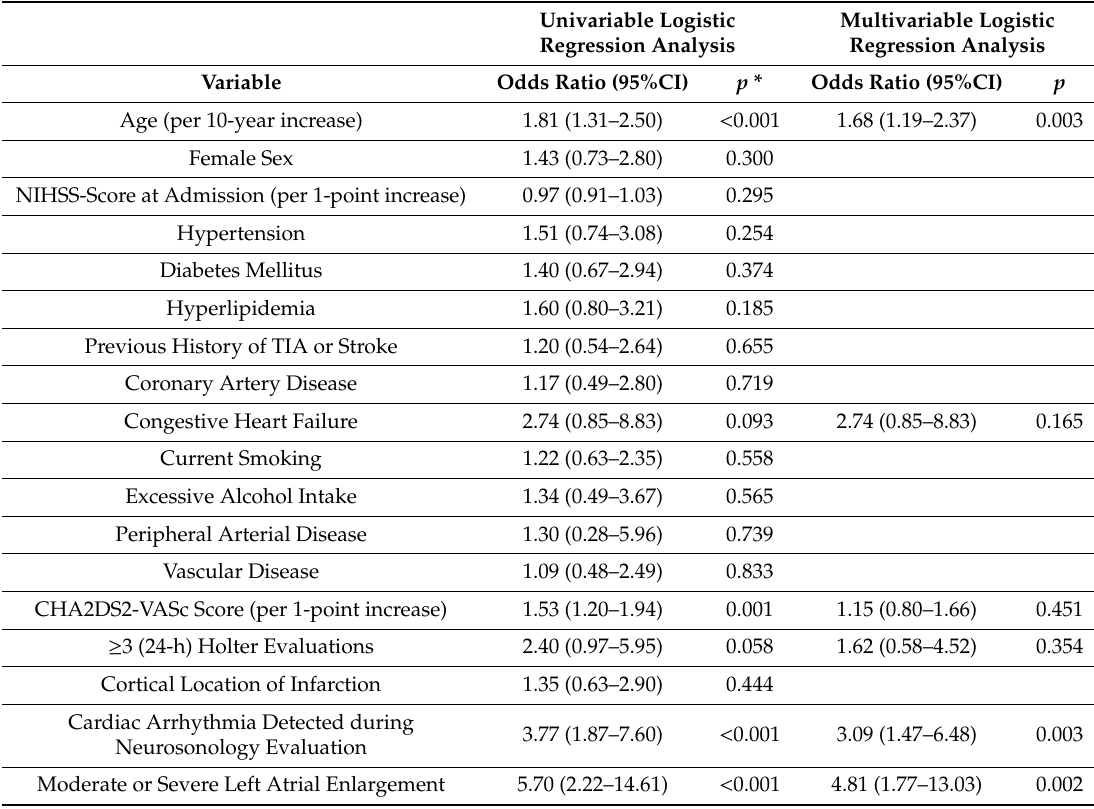
Table 4. Univariable and multivariable logistic regression analyses depicting the associations of baseline characteristics with the likelihood of atrial fibrillation detection during 24-h Holter